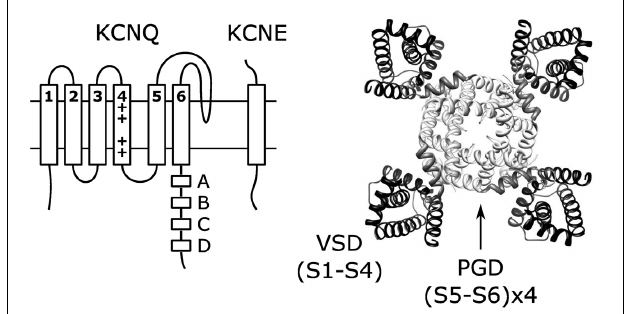
FIGURE 1 | Topology of single KCNQ subunit and the structure (right) of KCNQ channels formed by coassembly of four KCNQ subunits. The structure shown is the KCNQ1 homology model (Smith et al., 2007) based on the Kv1.2 crystal structure (Long et al., 2005).